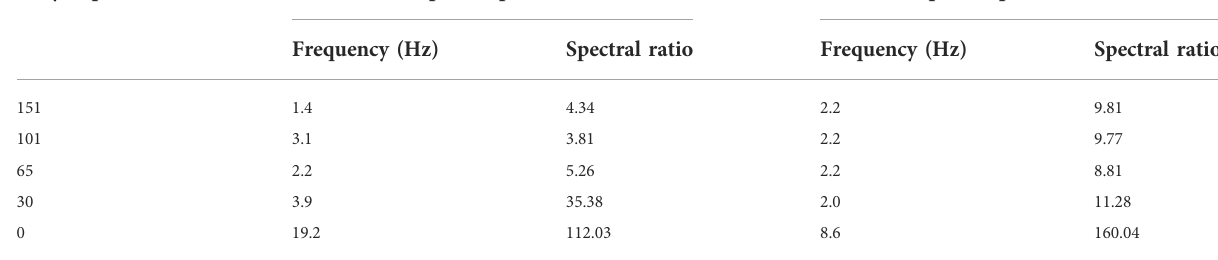
TABLE 5 Ampli fi cation factors and corresponding ampli fi cation frequencies observed at different bury depths of the SMASS table array in the Guye strong motion records (response spectrum ratios). Bury depth